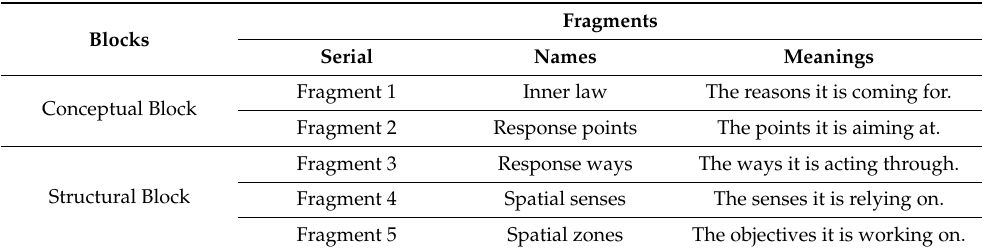
Table 1. The instructions of the blocks and sections for the DNA subchains.